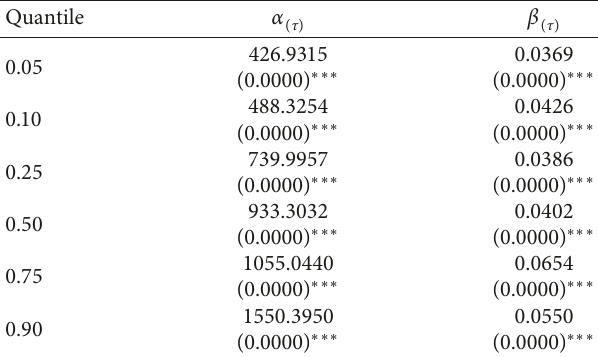
Table 3: Estimation results of quantile regression.